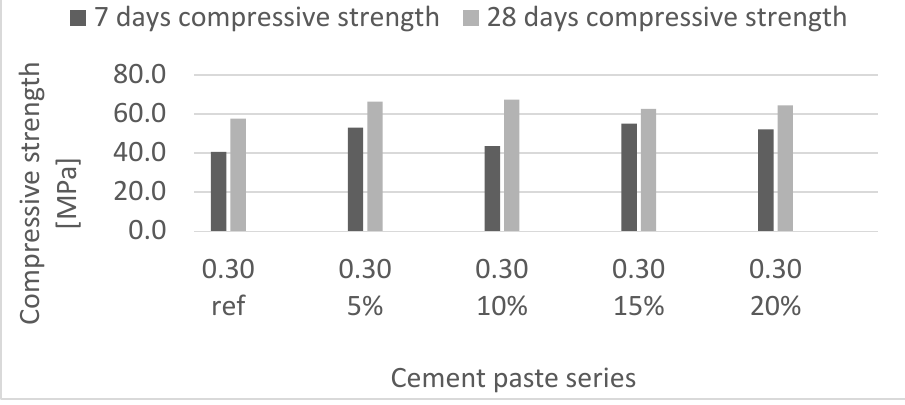
Figure 3. Effects of cement substitution with a spent FCC catalyst on the 7- and 28-day compressive strength of cement paste samples.